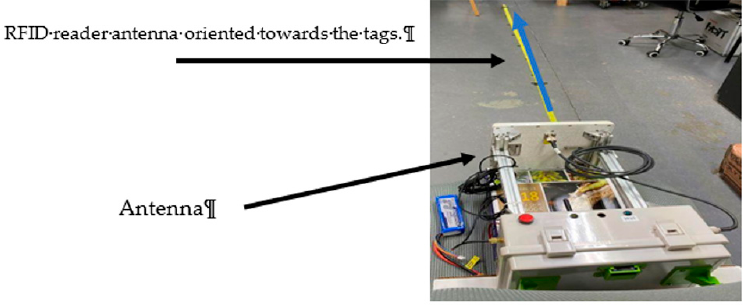
Figure 6. RFID-RM scanning tags during the first laboratory experiment. Table 2. Factors (2) evaluated in the first laboratory experiment for a total of nine treatments.